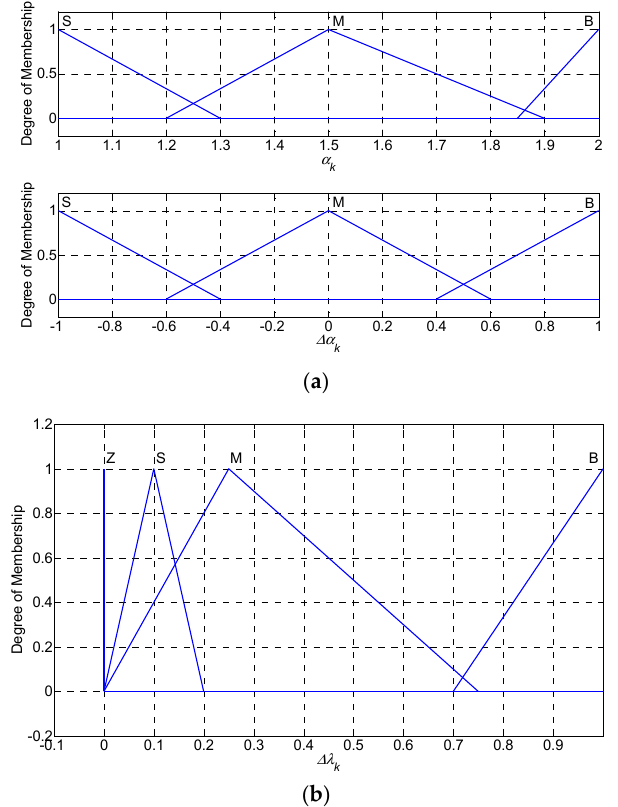
Figure 3. Membership function for adaptive fuzzy fading Kalman filter: ( a ) input fuzzy variables α k and Δ α k , ( b ) output fuzzy variable Δ λ k .